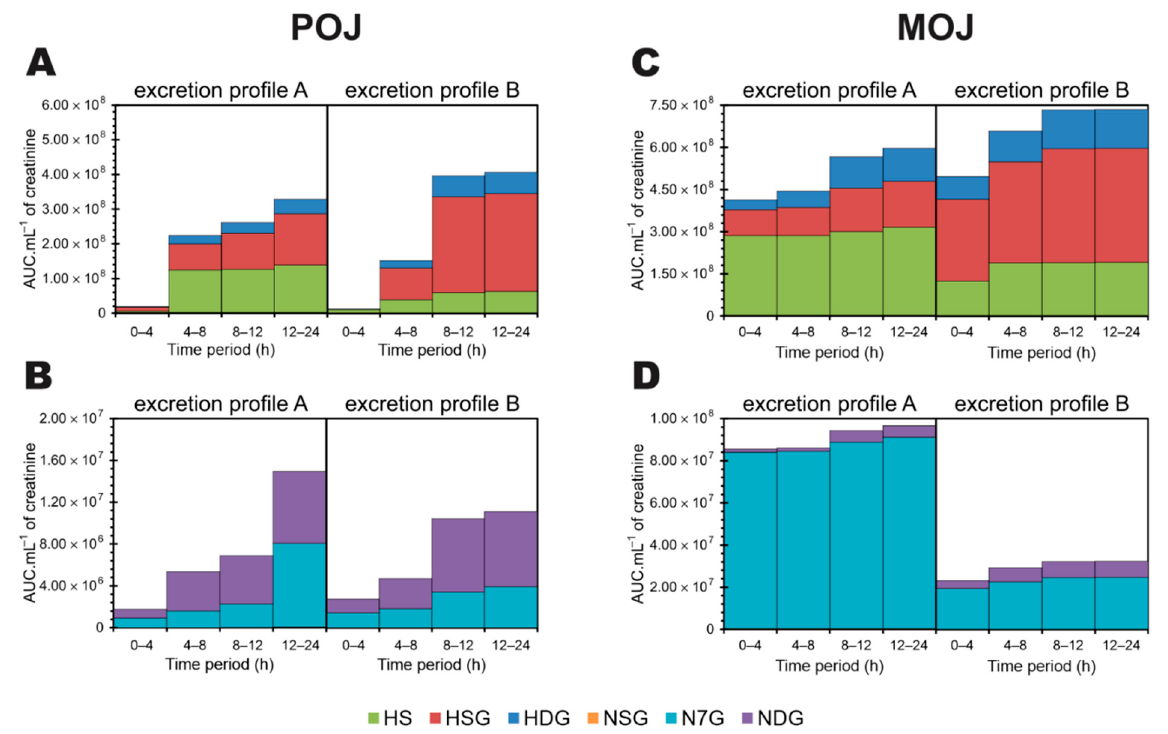
Figure 5. Recovery of urinary flavanone phase II metabolites over a 24-h period after single doses of Pera (POJ) ( A , B ) and Moro (MOJ) orange juices ( C , D ) for individuals classified as having Excretion Profiles A and B. Hesperetin metabolites ( A , C ) and naringenin metabolites ( B , D ) are shown (n of POJ = 10 volunteers with Profile A and 17 with Profile B; n of MOJ = 12 volunteers with Profile A and 15 with Profile B). HS: hesperetin-sulfate; HDG: hesperetin-diglucuronide; HSG: hesperetin-sulfo- O -glucuronide; NDG: naringenin-diglucuronide; NSG: naringenin-sulfo- O -glucuronide; N7G: naringenin- 7- O -glucuronide. AUC: Area Under the Curve.